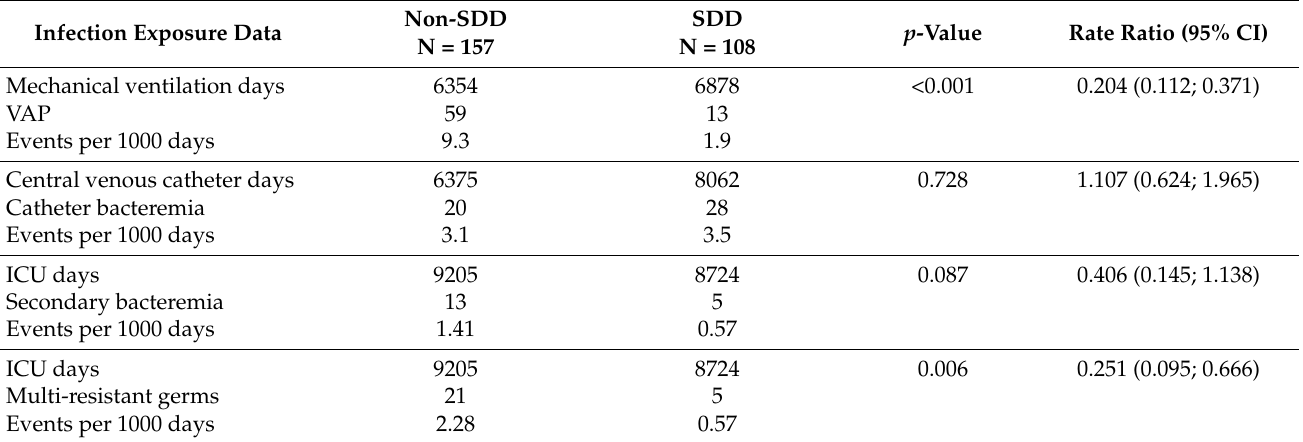
Table 2. Incidence of infections according to SDD regimen.